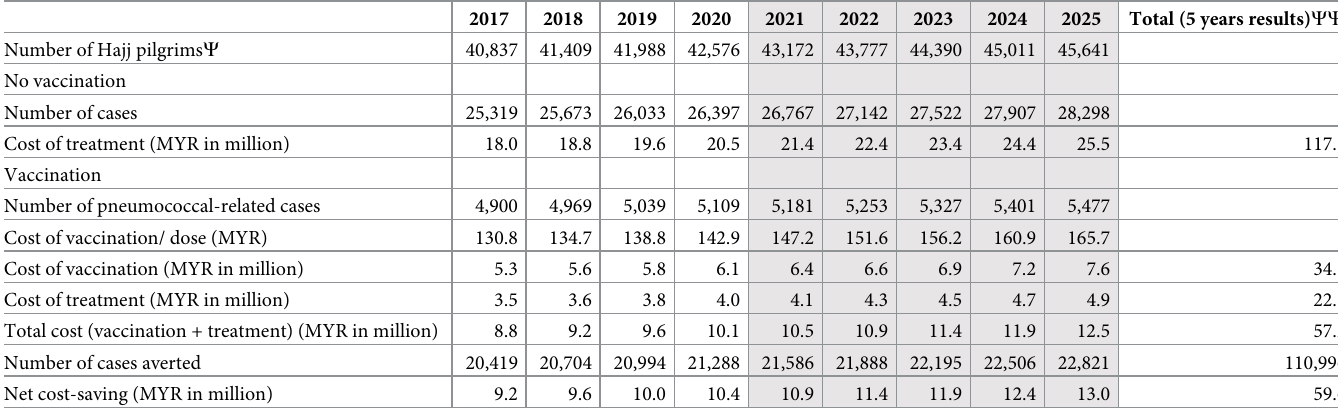
Table 6. Budget impact analysis of PPV23